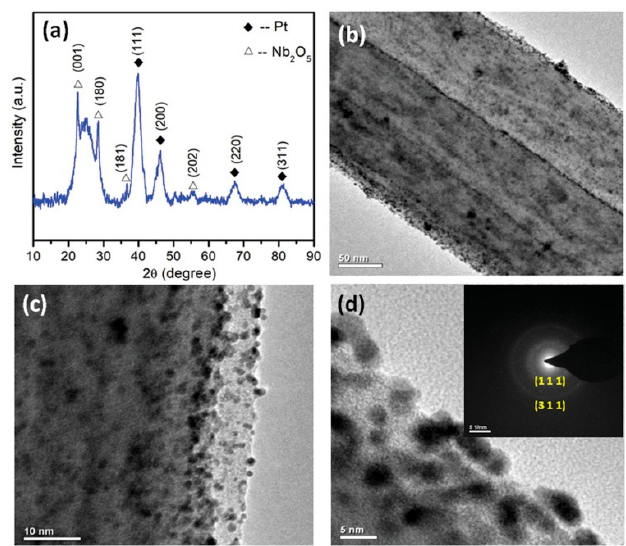
Figure 5. ( a ) X-Ray Diffractrogram (XRD) of Nb-CNF-Pt, ( b – d ) Transmission Electron Microscopy (TEM) images of Nb-CNF-Pt with inset of ( d ) representing the selected area electron diffraction (SAED) pattern of Nb-CNF-Pt. Reproduced with permission from Ref. [90]. Copyright, John Wiley and Sons 2019.